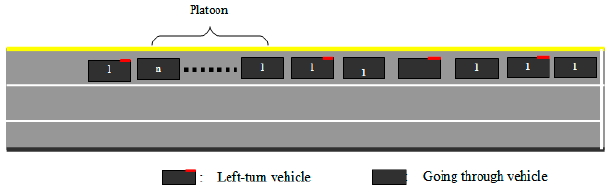
Figure 10. The through and left-turning vehicles appearing intermittently in the shared lane.